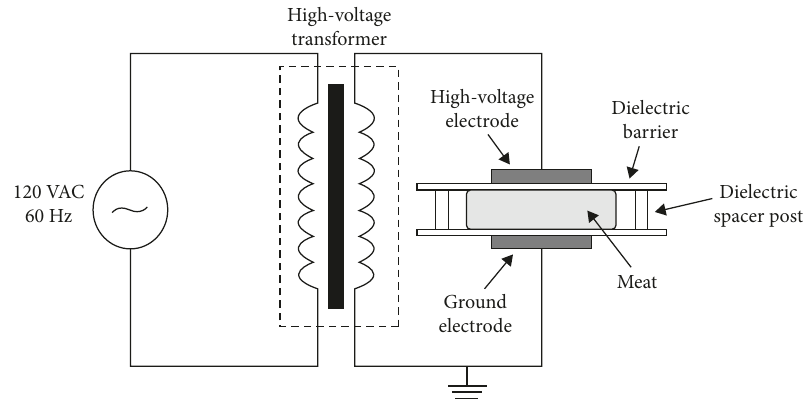
Figure 1: Schematic of in-package cold plasma treatment